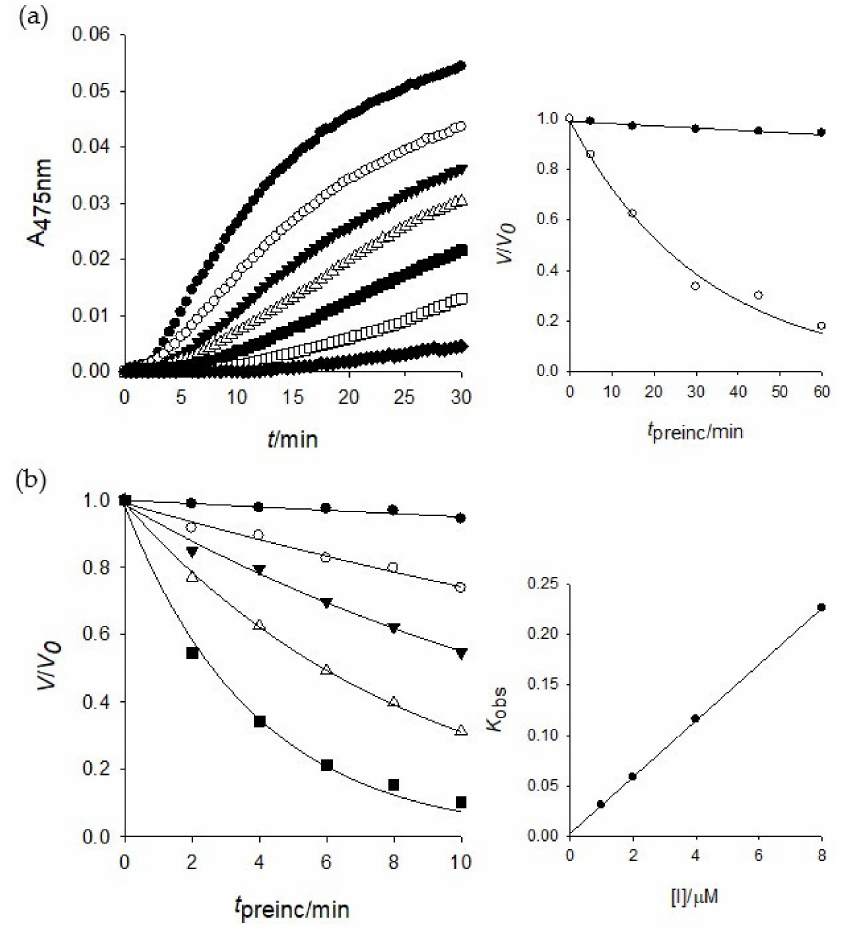
Figure 3. ( a ) Inhibition as a function of preincubation time ( • :